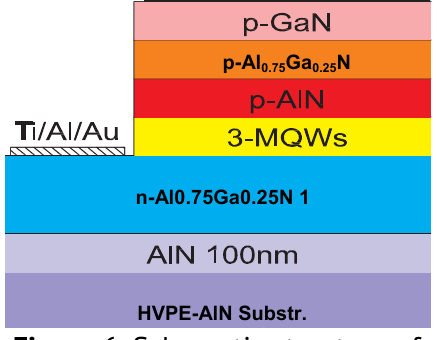
HVPE-AlN Substr. Figure 6. Schematic structure of a 268 nm DUV-LED